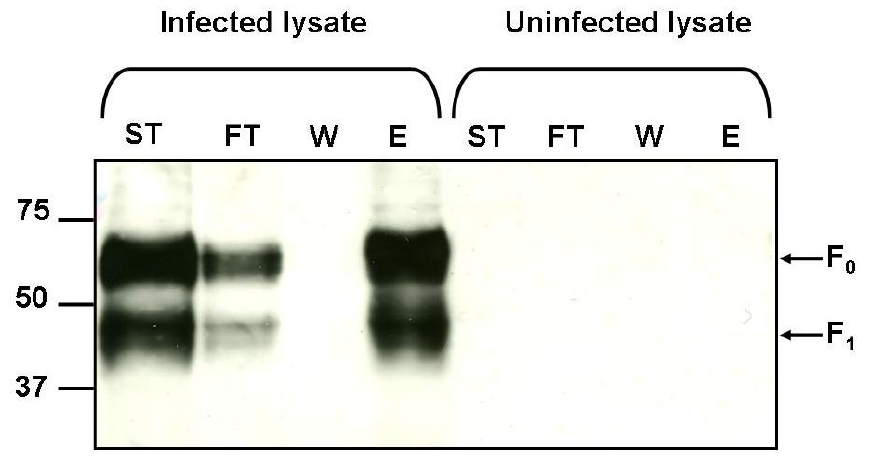
Figure 6. Binding of native hMPV F protein to heparin. Start material (ST), flow through (FT), wash (W) and 2M NaCl elution (E) fractions were analysed by 10% SDS-PAGE under reducing conditions and western blot analysis using anti-hMPV F antibody. Arrows indicate bands corresponding to the predicted sizes of full length precursor hMPV-F (F and the cleavage fragment hMPV F . Molecular weight markers are shown in kDa. 1